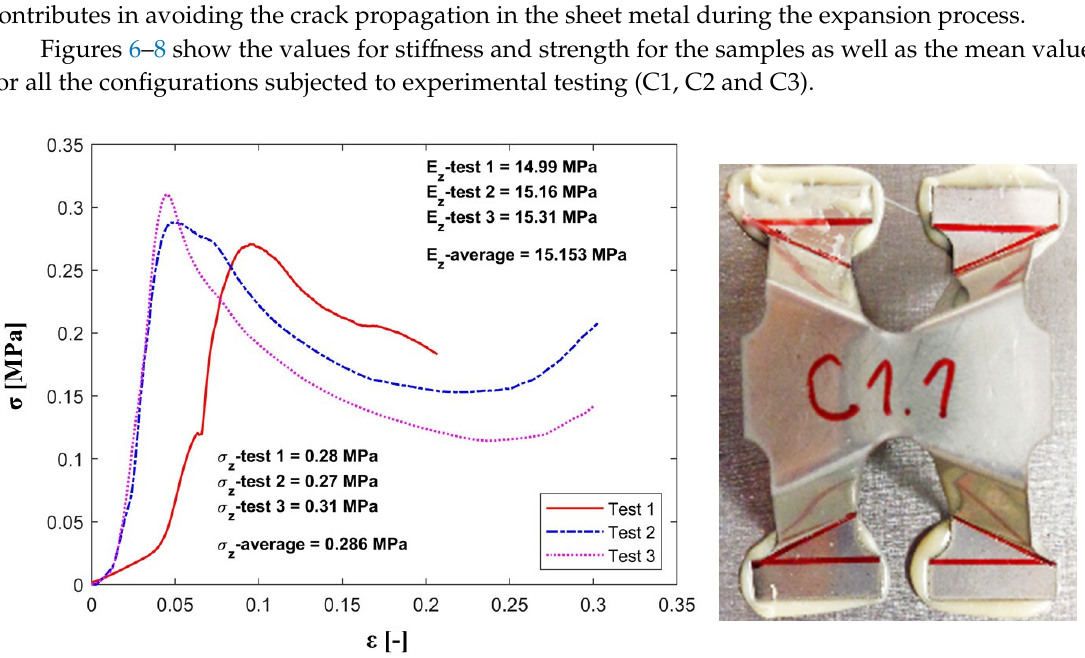
Figure 7. Stress-strain plot for the C2 configuration under out-of-plane compression.